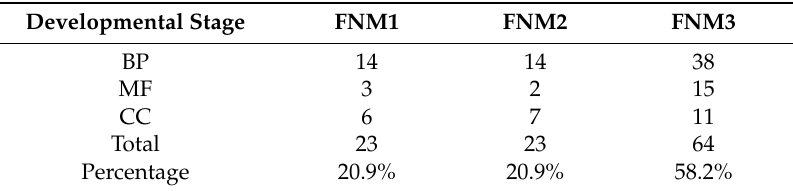
Table 5. Significantly enriched gene ontology (GO) terms in DEGs between FL and SL ovules in different stages among FNMM.